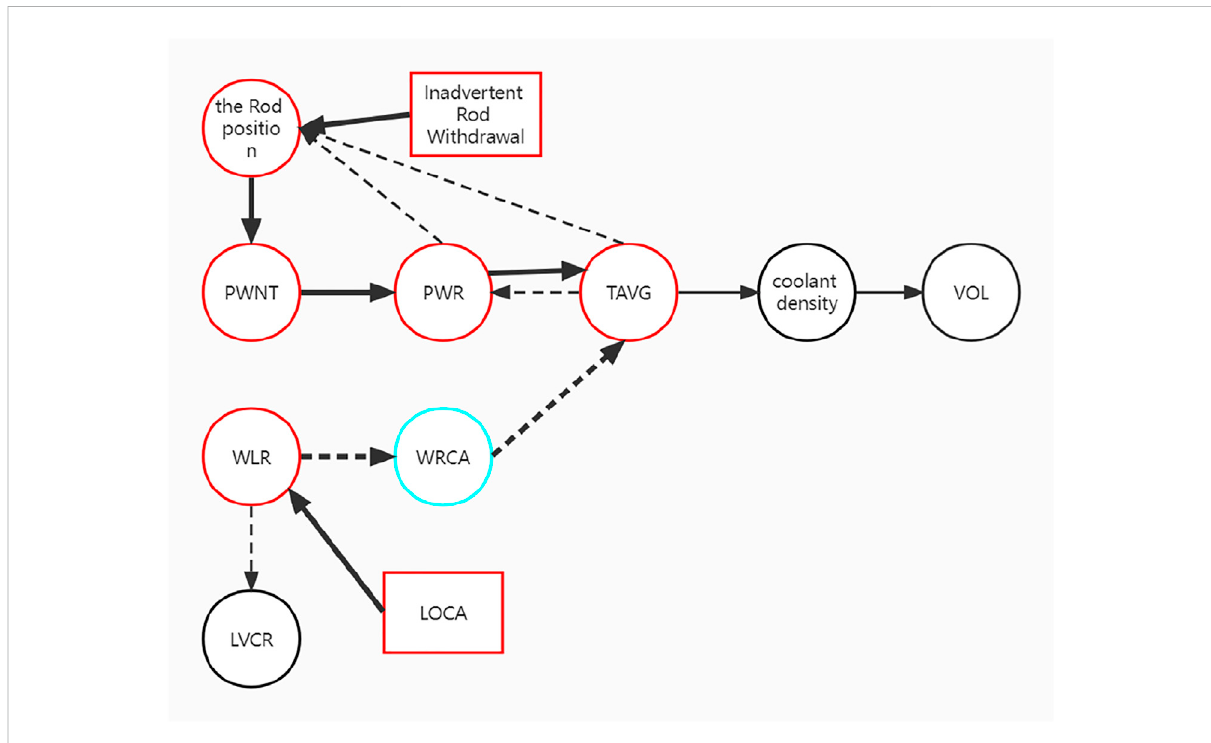
FIGURE 16 Reactor FR-SDG model for LOCA